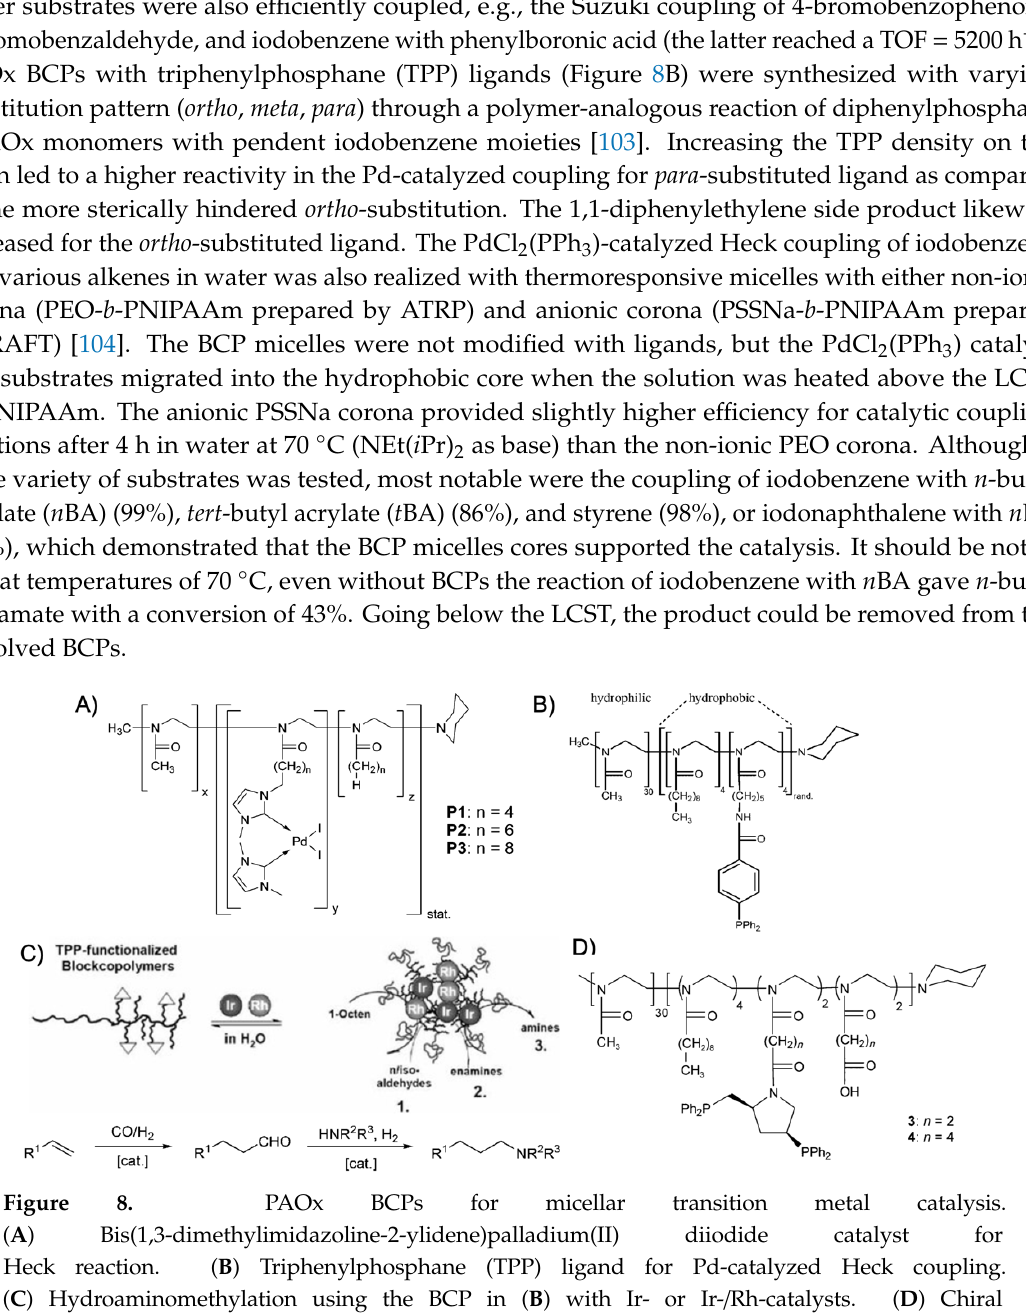
Figure 8. PAOx BCPs for micellar transition metal catalysis. ( A ) Bis(1,3-dimethylimidazoline-2-ylidene)palladium(II) diiodide catalyst for Heck